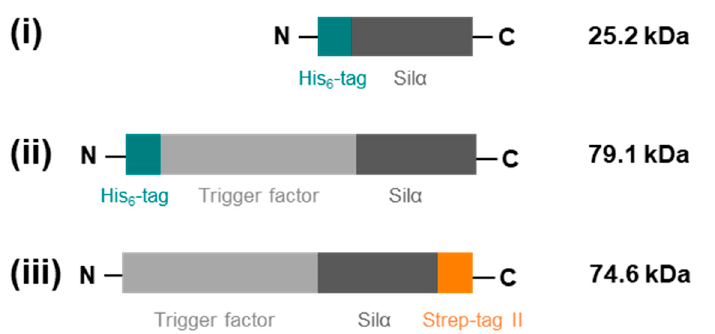
Figure 1. Schematic diagram showing protein constructs created: ( i ) His 6 -Sil α ; ( ii ) His 6 -TF-Sil α ; ( iii ) TF-Sil α -Strep. For convenience, N- and C-termini are indicated, together with the molecular weight of each fusion protein.